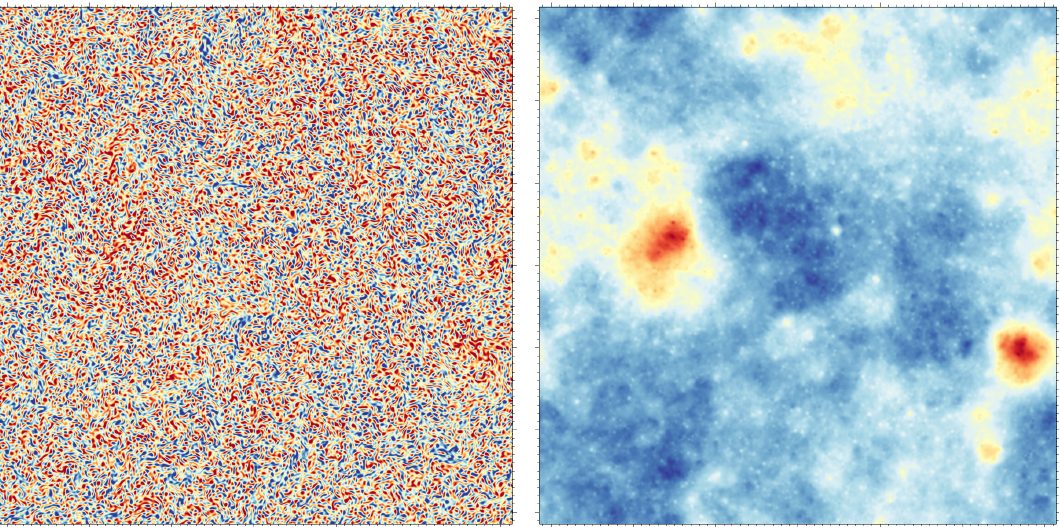
Figure 1 . Left panel : snapshot of vorticity for homogenous isotropic F i -driven turbulence of a black brane horizon at t = 24 L . The time evolution resembles that of a vortex liquid flowing coherently as part of larger vortical structures, not apparent in this snapshot. The correlation functions of this velocity field are consistent with K41 scaling relations. Right panel : snapshot of energy density, a , for homogenous isotropic F -driven turbulence of a black brane horizon at t = 24 L , for the evolution i in figure 1 (left). Inhomogeneities have amplitudes of order 10% of the local energy density. At this time in the evolution, energy at high scales is beginning to ‘condense’ into a vortex lattice at large scales, dictated by the finite size L of the setup.